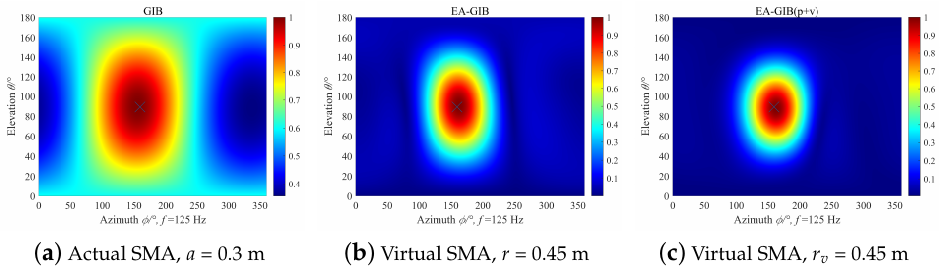
Figure 5. Simulation results of the single sound source with the frequency 125 Hz.